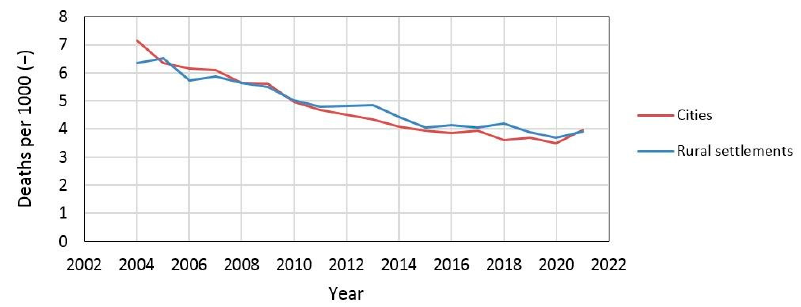
Figure 17. Infant deaths per 1000 in urban and rural regions of Poland, 2004–2021, data obtained from [66].